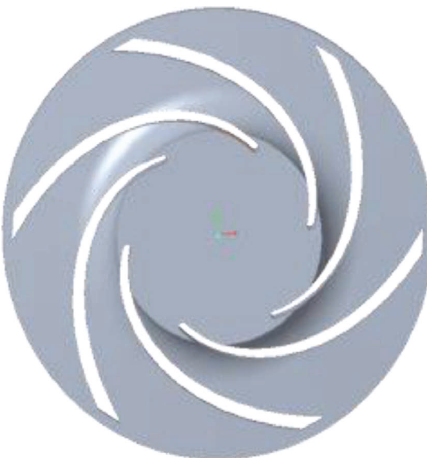
Figure 3: Hydraulic model of the blade.